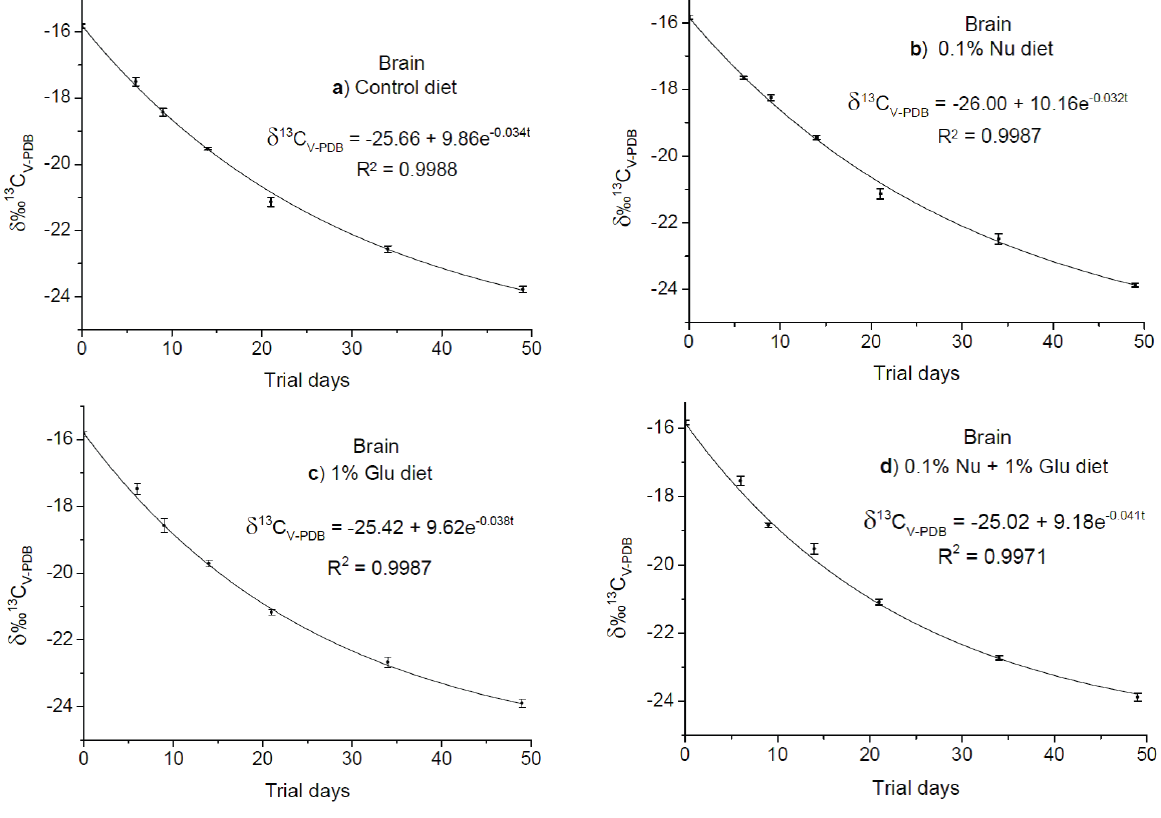
) of piglets’ brain ( a ): control diet, ( b ): 0.1% nucleotides, ( c ): V-PDB